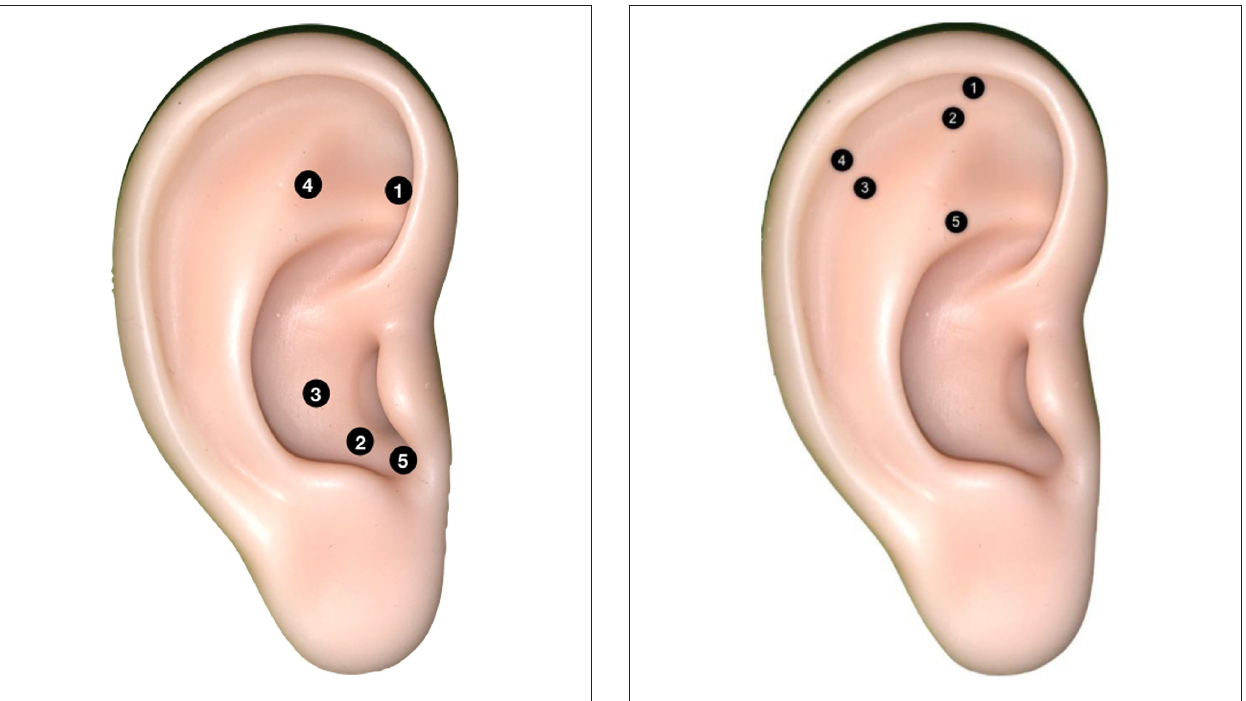
FIGURE 3 | The control (non-anxiety-reducing) auricular acupressure points are used for APT. 1. Heel point (MA-AH1), 2. Ankle point (MA-AH2), 3. Knee point (MA-AH3), 4. Hip point (MA-AH4), and 5. Buttock point